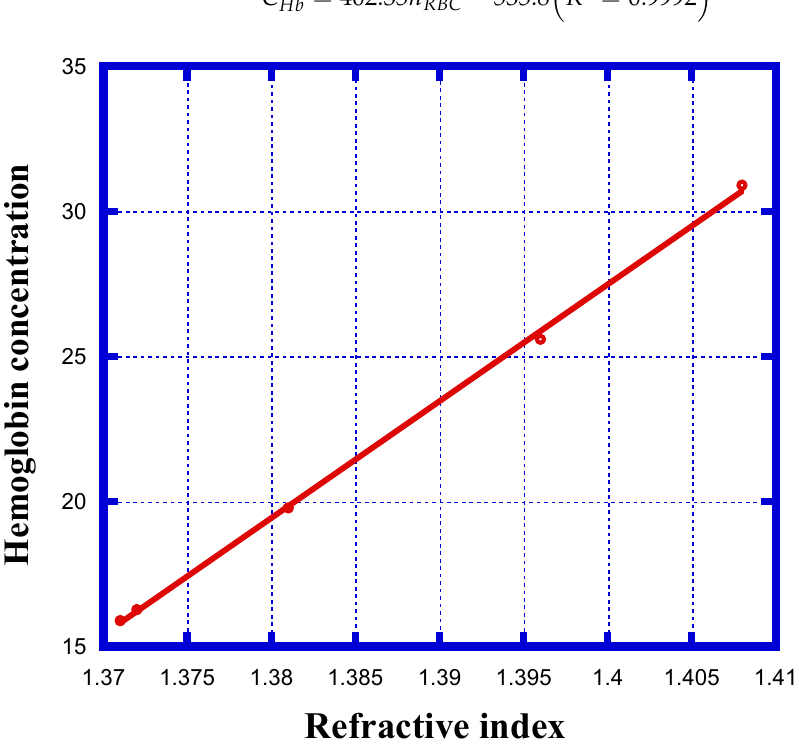
Figure 2. The diagram showing refractive index of RBC components containing cells A, B, C, D and E dependent upon the hemoglobin concentration of blood.